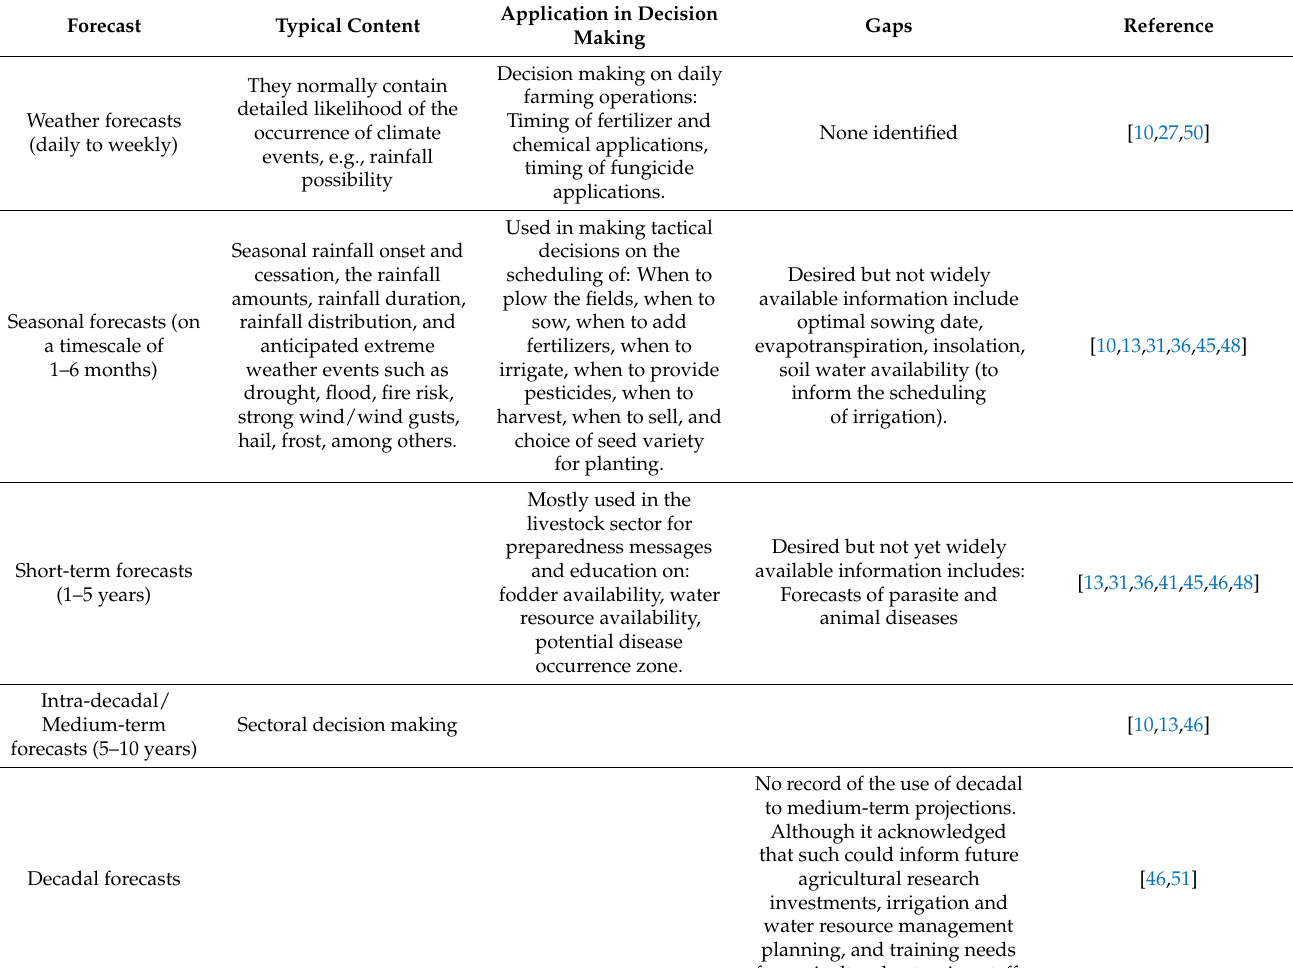
Table 2. Observed forecasts and their use in the agriculture